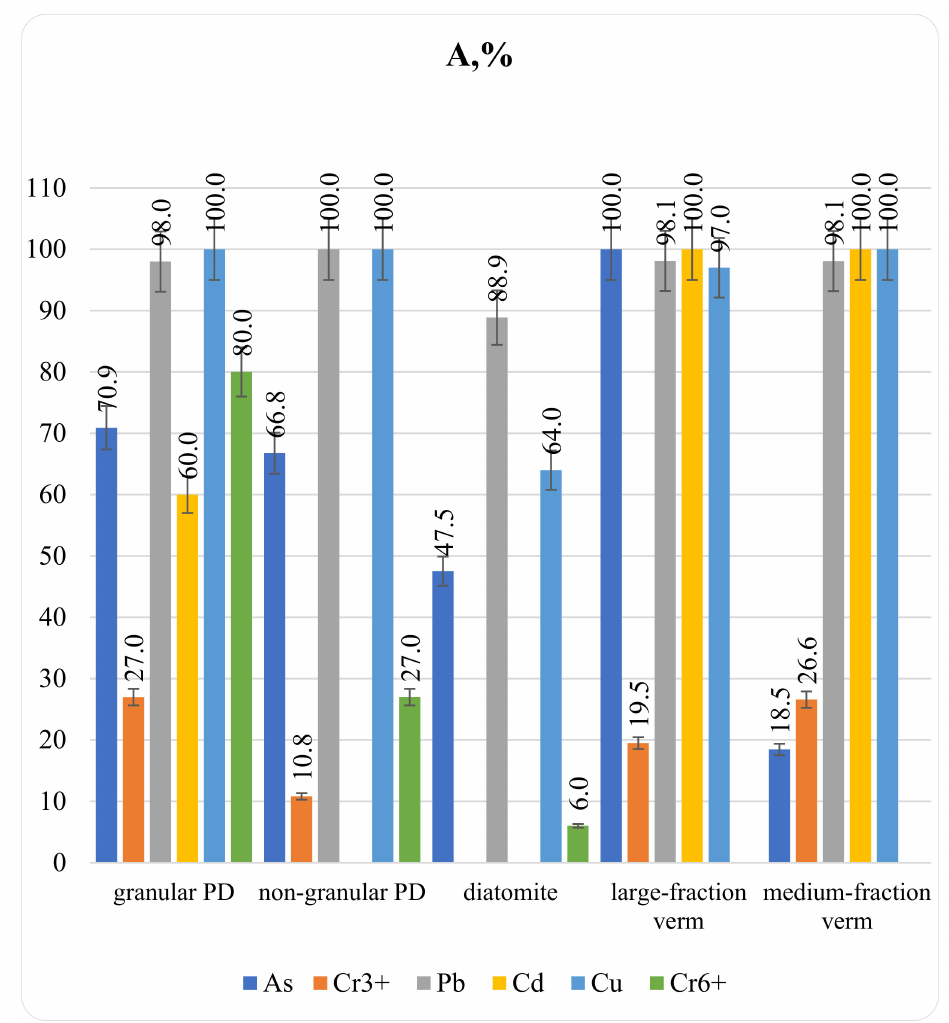
Figure 1. Efficiency of the sorbents (A) in relation to the grade of heavy metal ion extraction from the model